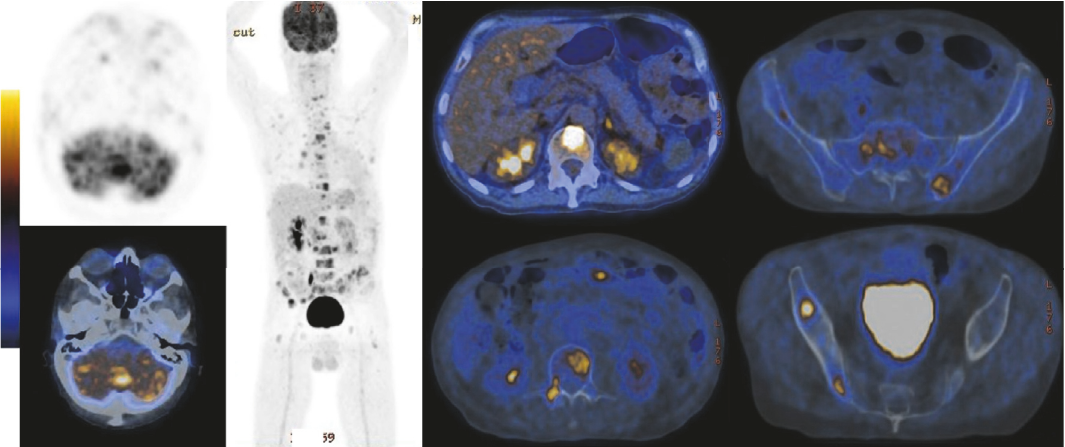
Figure 4: 18-Fluorodeoxyglucose positron emission tomography revealing a hypermetabolic lesion at the common bile duct/duodenum topography with cerebellar, thoracic-abdominal lymph nodes, left suprarenal gland, and bone